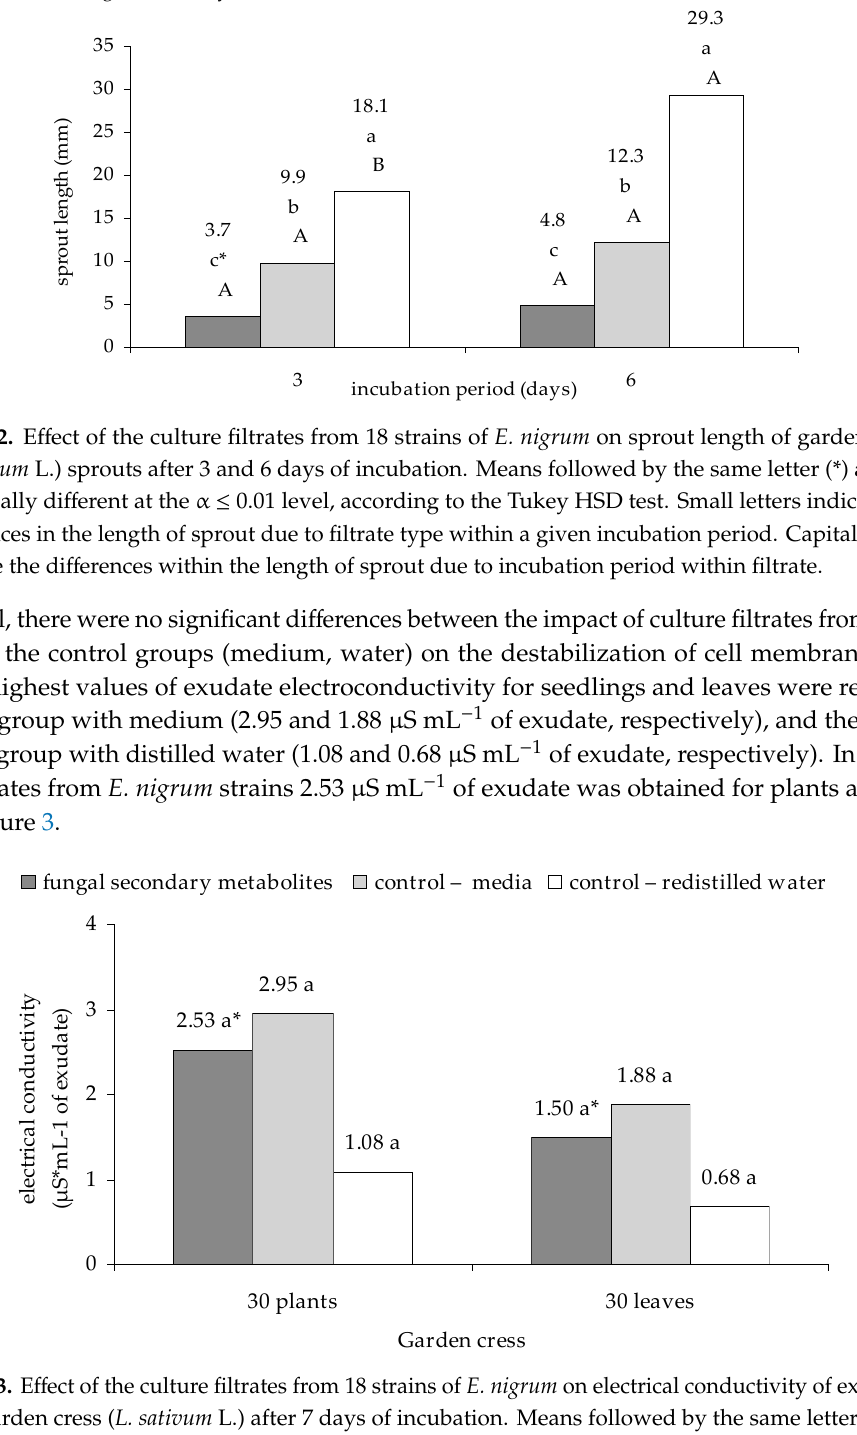
Figure 2. Effect of the culture filtrates from 18 strains of E. nigrum on sprout length of garden cress ( L. sativum L.) sprouts after 3 and 6 days of incubation. Means followed by the same letter (*) are not statistically different at the α ≤ 0.01 level, according to the Tukey HSD test. Small letters indicate the differences in the length of sprout due to filtrate type within a given incubation period. Capital letters indicate the differences within the length of sprout due to incubation period within filtrate.